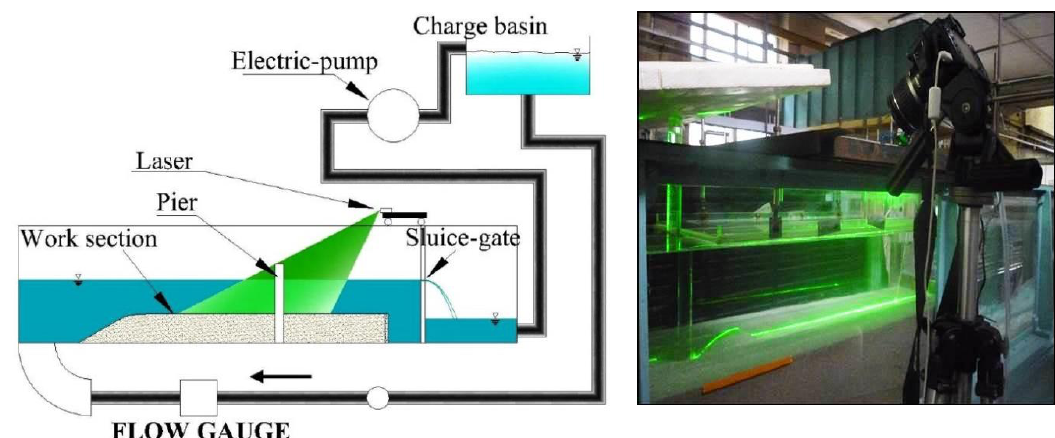
Figure 1. Schematic of the water c ircuit and test section. The laser sheet is highlighted in green.